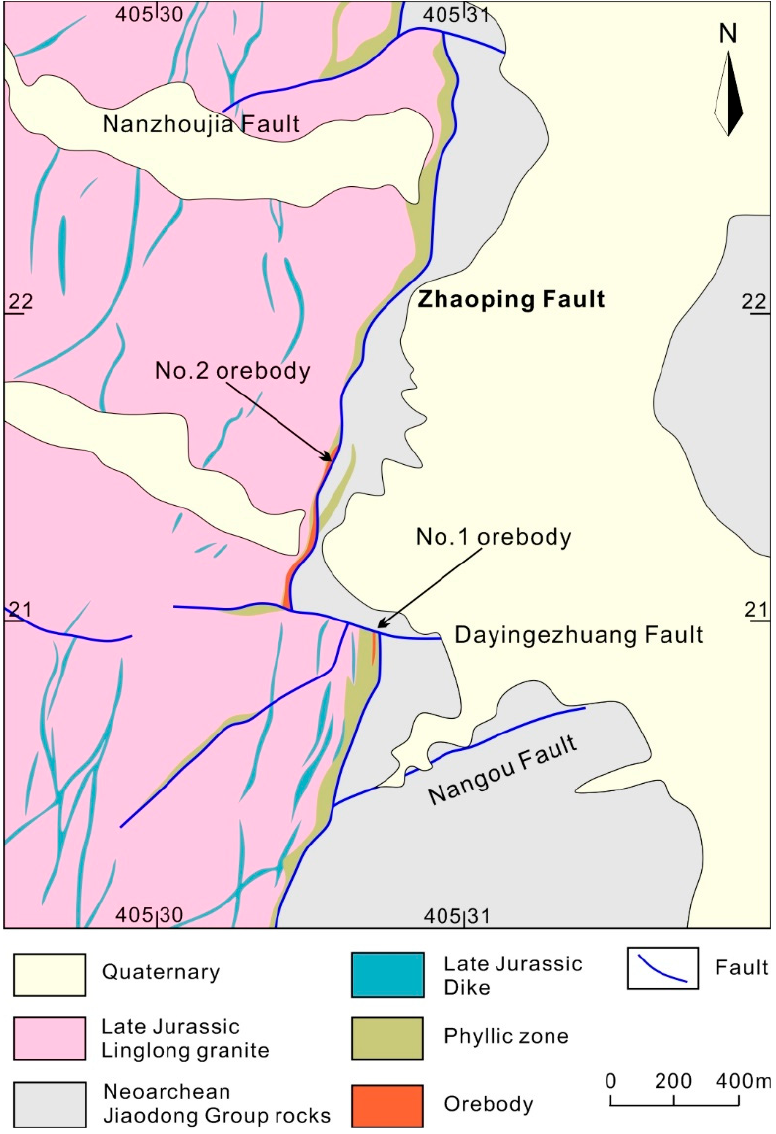
Figure 2. A simplified geological map of the Dayingezhuang gold deposit [37]. Two types of ore (disseminated and quartz vein) have been distinguished in the Dayingezhuang gold deposit [11]. Disseminated ore occurs in the footwall of the Zhaoping fault with relatively large reserves (90%) and low grades (<5 g/t), and it is linked to breccia- tion and intense quartz–pyrite–sericite alteration. Vein-type ores have smaller reserves but higher grades (typically >8 g/t), and mainly occur in secondary faults and fractures in the phyllic alteration footwall zone or with weak quartz–pyrite–sericite alteration, which occurs at varying distances from the Zhaoping fault [37–41]. The timing of the Dayingezhuang gold mineralization was reported to be ca. 133 to 127 Ma, which is slightly earlier than other gold deposits in the Jiaodong Peninsula [13]. The trapping temperatures of the fluid inclusions (CO 2 –H 2 O, aqueous fluid, and CO 2 –H 2 O ± CH 4 ) in Au-bearing quartz veins at Dayingezhuang are between 360 and 280 ◦ C